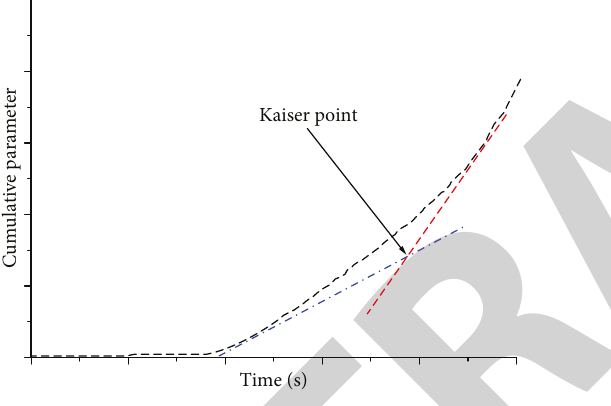
Figure 3: Kaiser point interpretation of the cumulative parameter curve of the fuzzy in fl ection